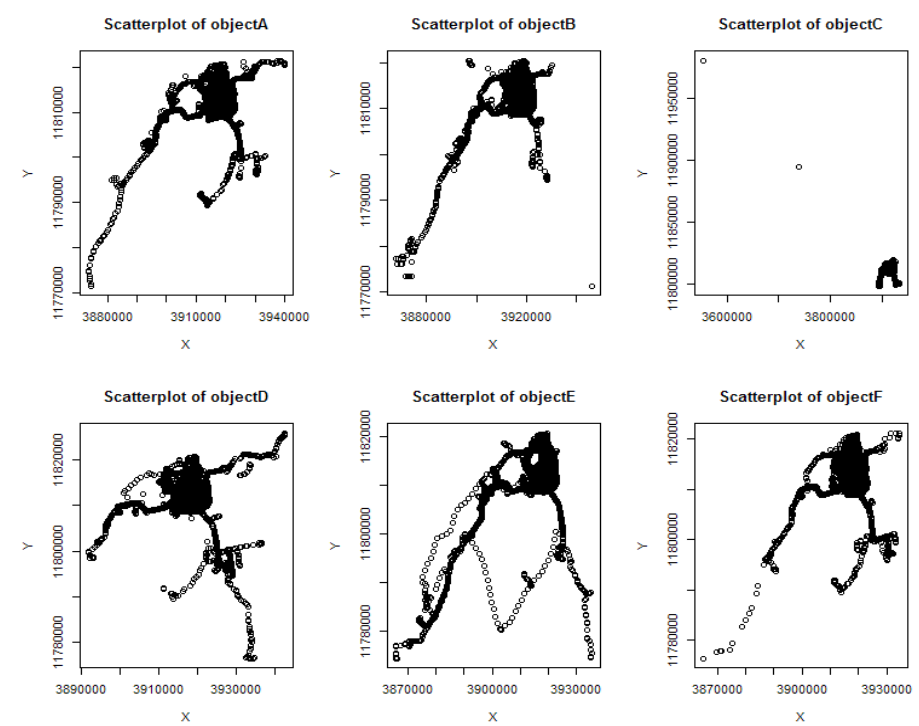
Figure 5. The scatter plot of object original locations.